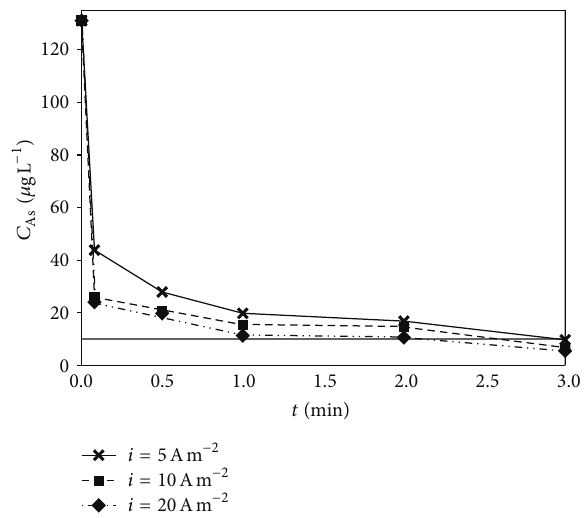
Figure 2: Variation of total As concentration in the reactor during the EC process using a feedwater flow rate of 0.50 Lmin −1 and current densities of 5, 10, and 20 Am −2 .